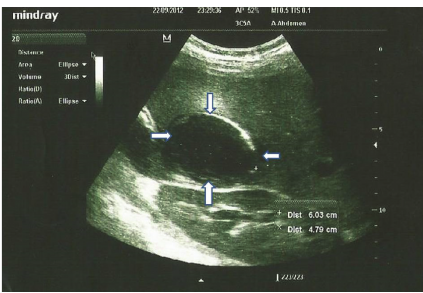
Figure 1: The abdominal ultrasound image of calcified wall of the abscess in 23-week pregnant